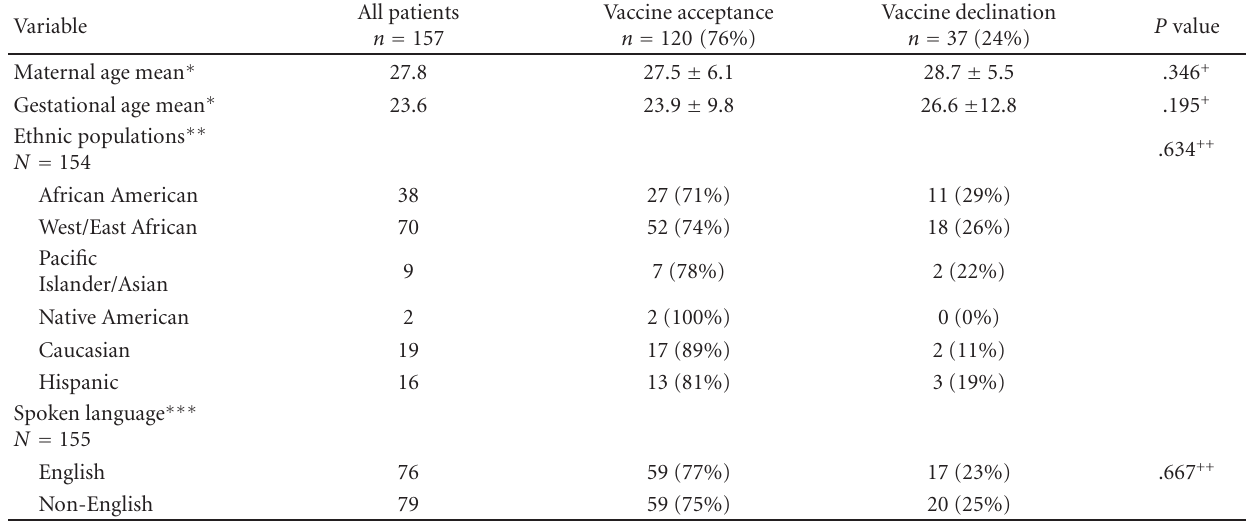
Table 1: Demographic and outcome characteristics of vaccinated versus unvaccinated HMC obstetric